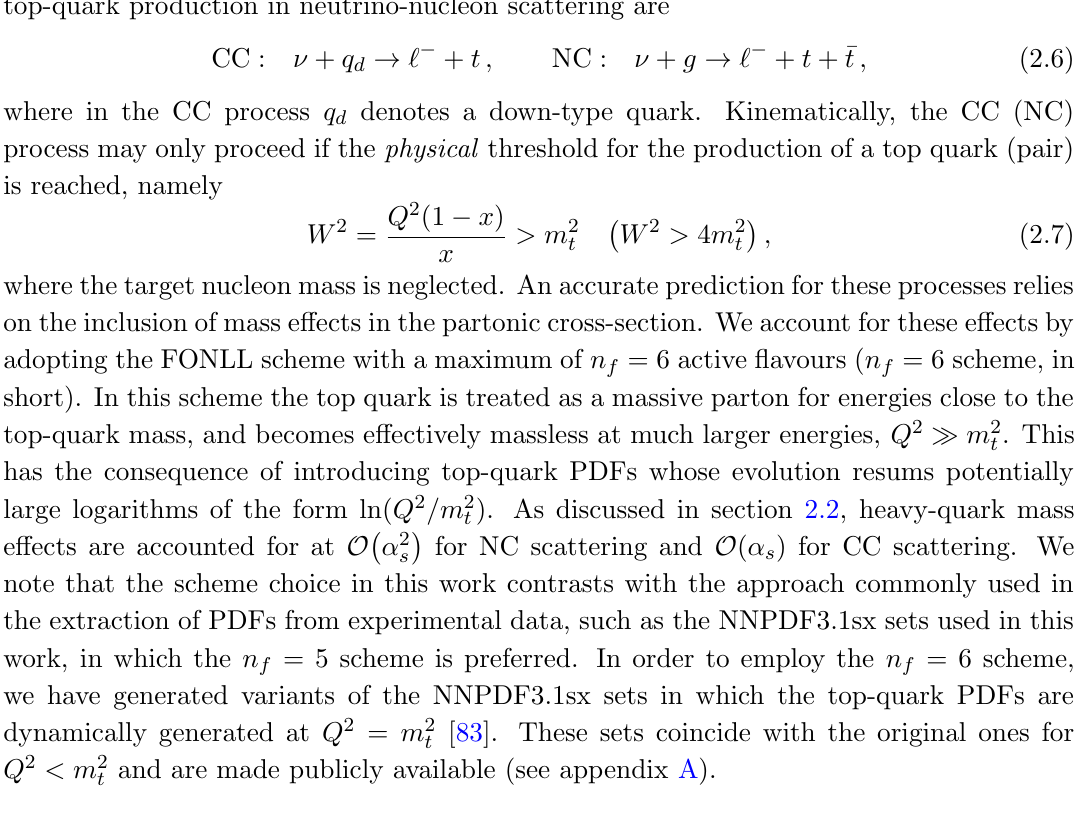
is taken to decouple the e(cid:11)ects ! 1